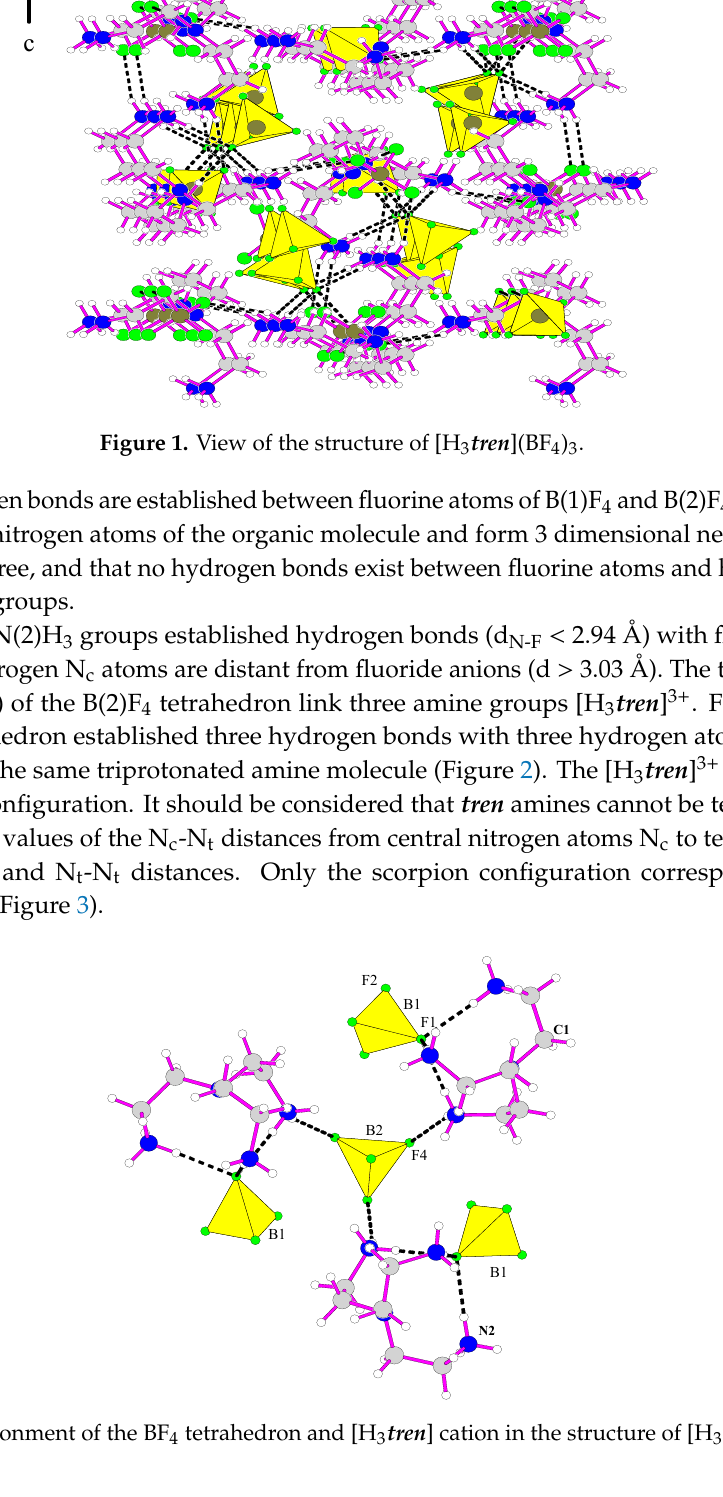
Figure 3. Configuration spider ( left ), plane ( middle ) and scorpion ( right ) of the tren amine. 3.2. Structure Description of [H 3 tren](BF 4 ) 3 HF (II) The projection of the structure along the c direction is given in Figure 4. The asymmetric unit of the structure of [H 3 tren ](BF 4 ) 3 HF is composed of ethylene diamine groups and distorted BF 4- tetrahedron anions. One can see that the disordered fluorine atoms have high atomic displacement parameters. Atomic displacement parameters of terminal nitrogen atoms are almost greater than tertiary amine group (Figure S1, right in the ESI). In the structure of [H 3 tren ](BF 4 ) 3 HF, the environment of boron is disordered. It is composed of four fluorine atoms; among them, two occupy a general position with a 50% occupancy factor. The distances B-F vary between 1.29 and 1.44 Å, with an average of 1.36 Å. Distances between disordered fluorine atoms are 0.76(3) and 0.77(2) for F(2)-F(2)p and F(4)-F(4)p, respectively. Distances between two non-equivalent fluorine atoms vary between 2.17 and 2.3 Å. Hydrogen bonds are established between fluorine atoms of hydrofluoric acid and three hydrogen atoms, each one belongs to one terminal NH 3 groups of the one organic molecules (Figure 5). In addition, each of the organic molecules established via NH 3 groups hydrogen bonds with F(2), F(3) and F. A total of 15 hydrogen bonds are observed between organic molecules and inorganic part. Concerning the organic moiety, the amine is triproptonated [H 3 tren ] 3+ and adopts a “spider” type configuration. Indeed, the values of the N c -N t distances from central nitrogen atoms N c to terminal nitrogen atoms N t (3.147 Å), as well as N t -N t distances (4.67 Å), agree with triprotonated amine. The